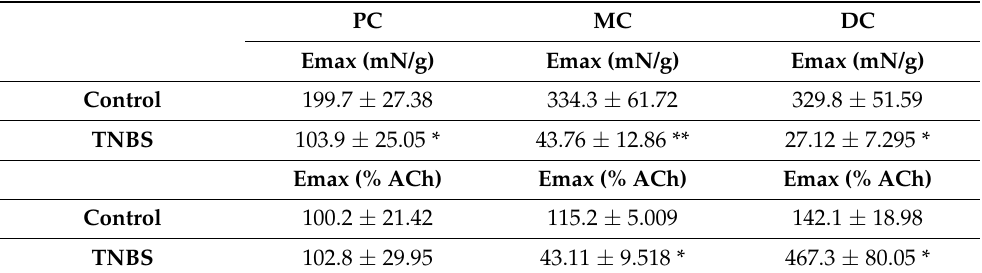
Table 1. E max (mN/g and %ACh) for Ang II-mediated contraction in the PC, MC and DC of control and TNBS-induced rats.